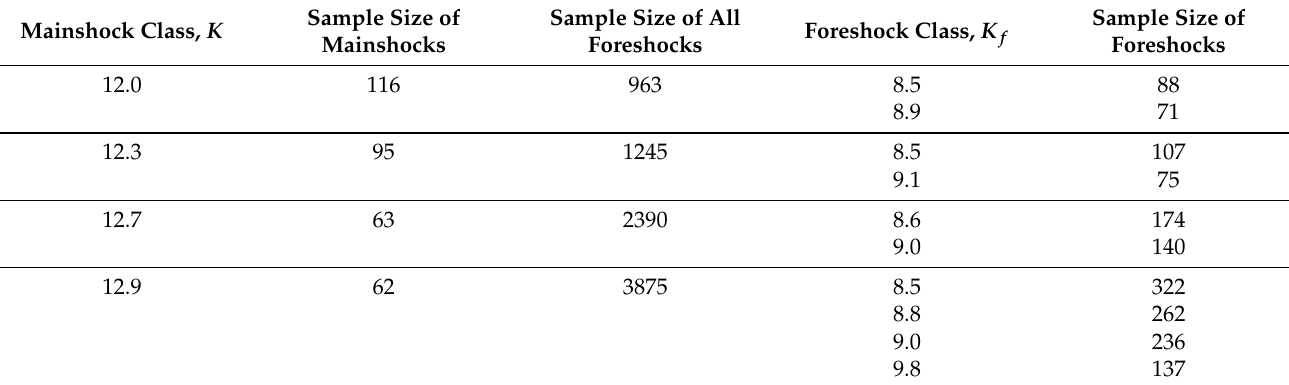
Table 1. Characteristics of foreshock